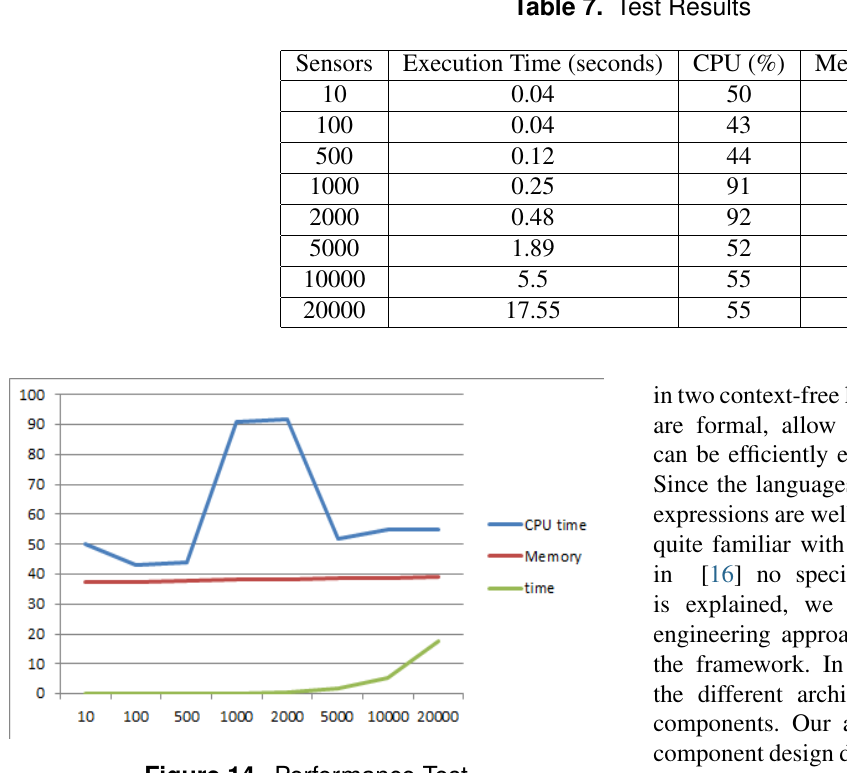
Figure 14. Performance